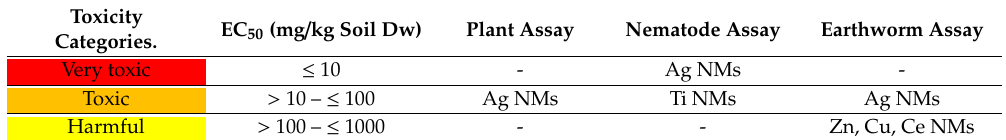
Harmful > 100 – ≤ 1000 - - Zn, Cu, Ce